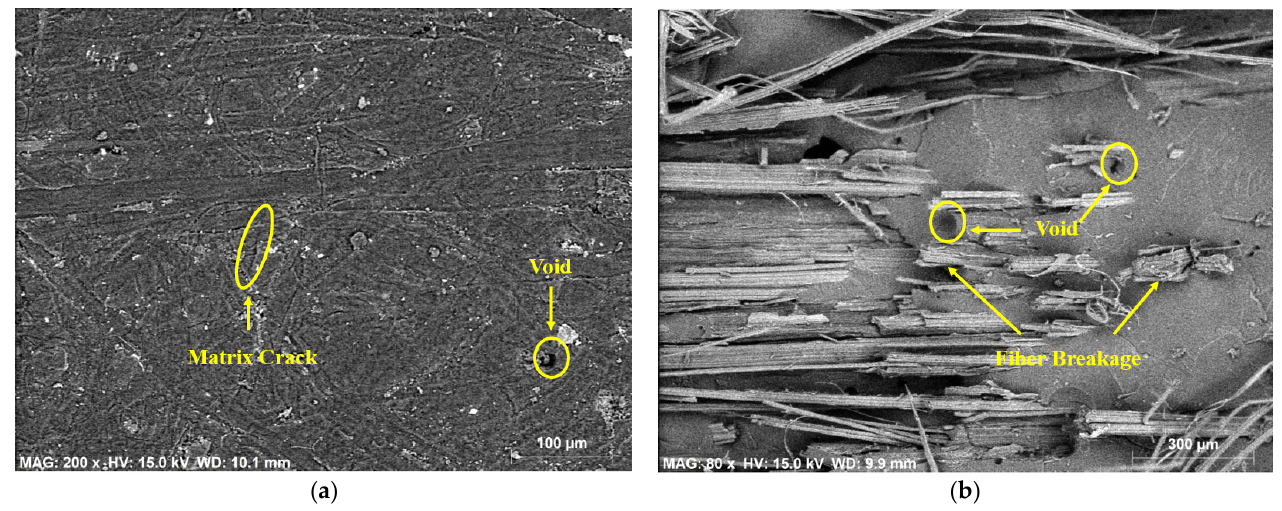
Figure 7. SEM EDX analysis of flax fiber reinforced epoxy composite at surface ( a ) and fracture ( b ) positions.